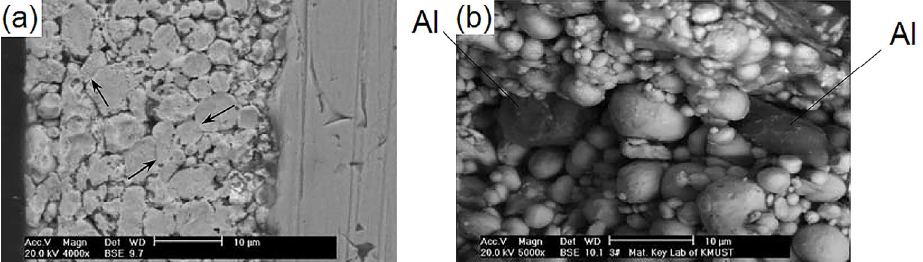
Fig. 11 Scanning electron micrograph of mechanically plated Zn ‒ Al coating from (a) cross section showing highly porous structure and the mark arrows show bonding at the interfaces between particles, and (b) fracture surface showing that the particles are mechanically bonded to each other. Reproduced with permission from Ref. [60], Licensed under CC BY,